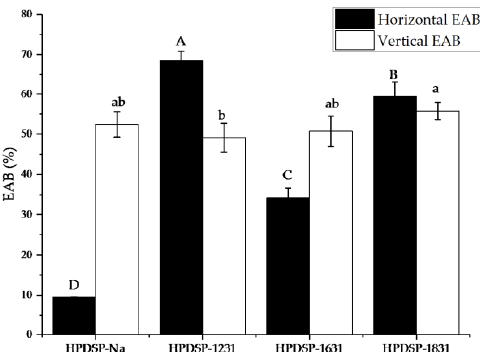
a–d: Different letters indicate significant differences among formulations ( p < 0.05).